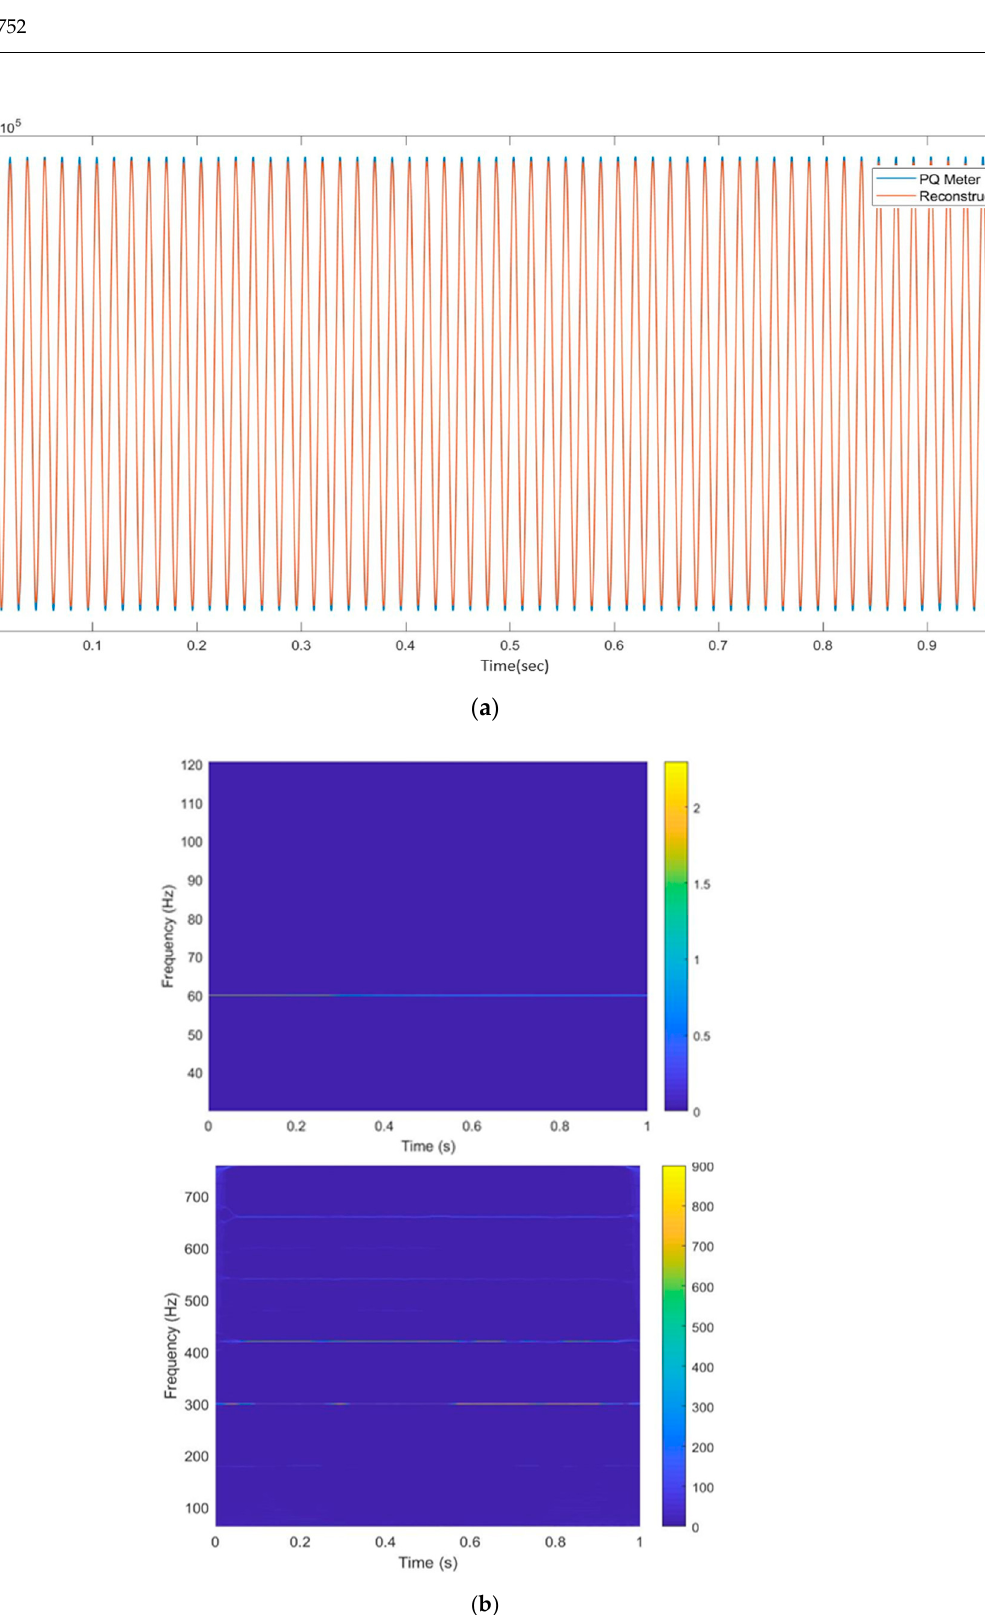
Figure 12. Offshore wind farm case: ( a ) the actual measured current waveform and reconstructed one using the proposed method, ( b ) time–frequency ridges.